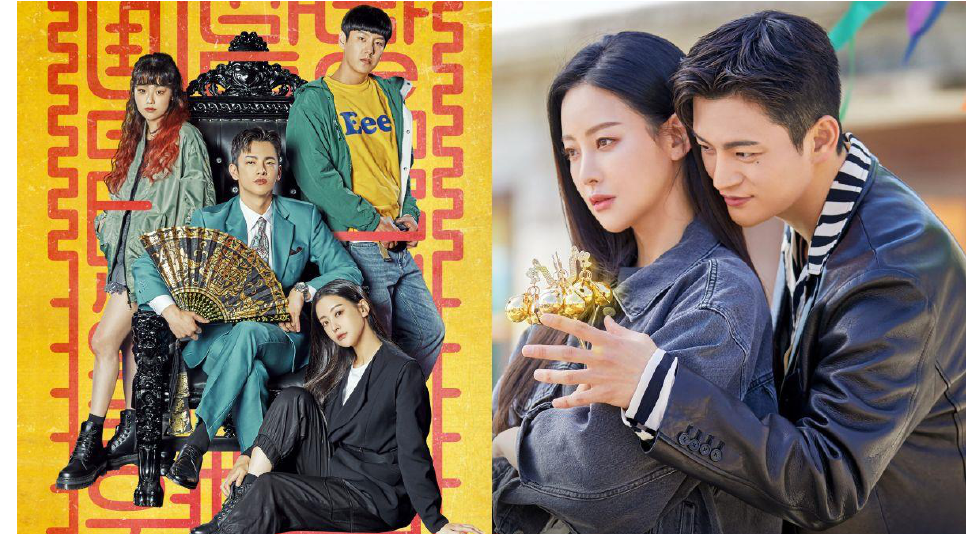
Figure 2. Café Minamdang, Promotional Poster and main characters. 2022, image KBS2. Figure 2. Caf é Minamdang, Promotional Poster and main characters, 2022, image